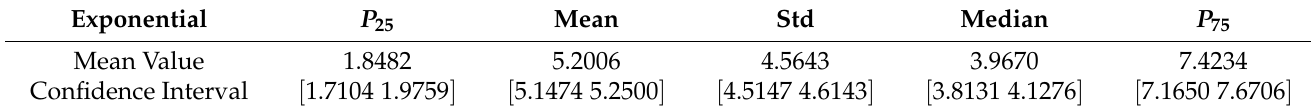
Table 4. Mean value and confidence intervals for the 2000 synthetic data collections.